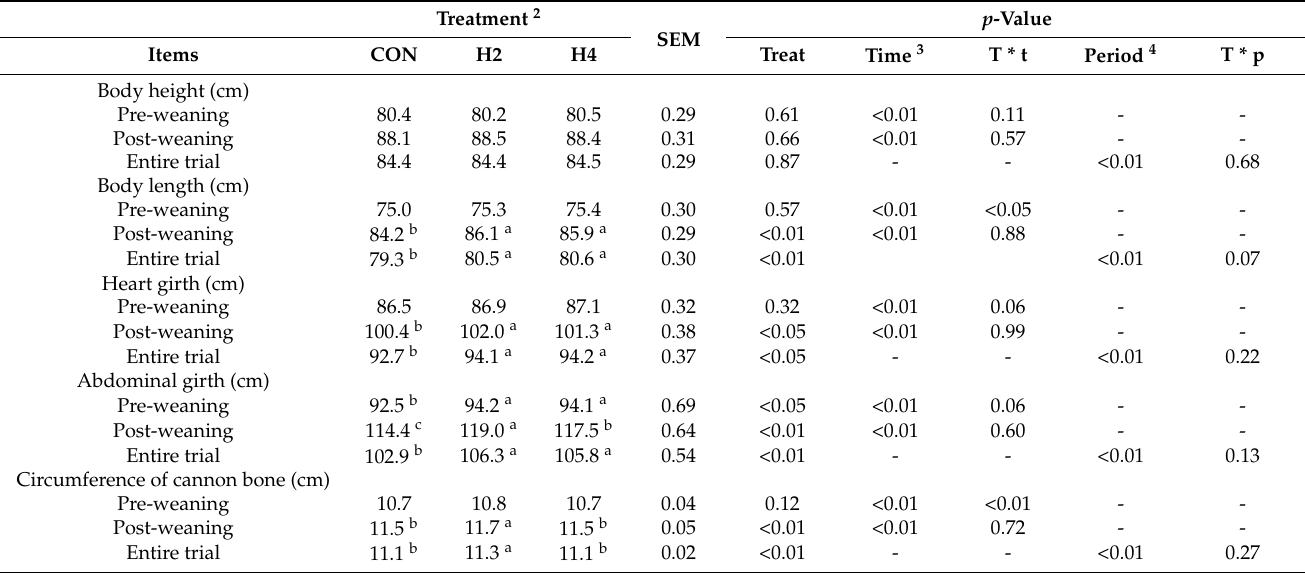
Table 4. Effects of hay supplementation at different ages on body structural growth in dairy calves during different periods 1 (CON: n = 70; H2: n = 70; H4: n = 70).